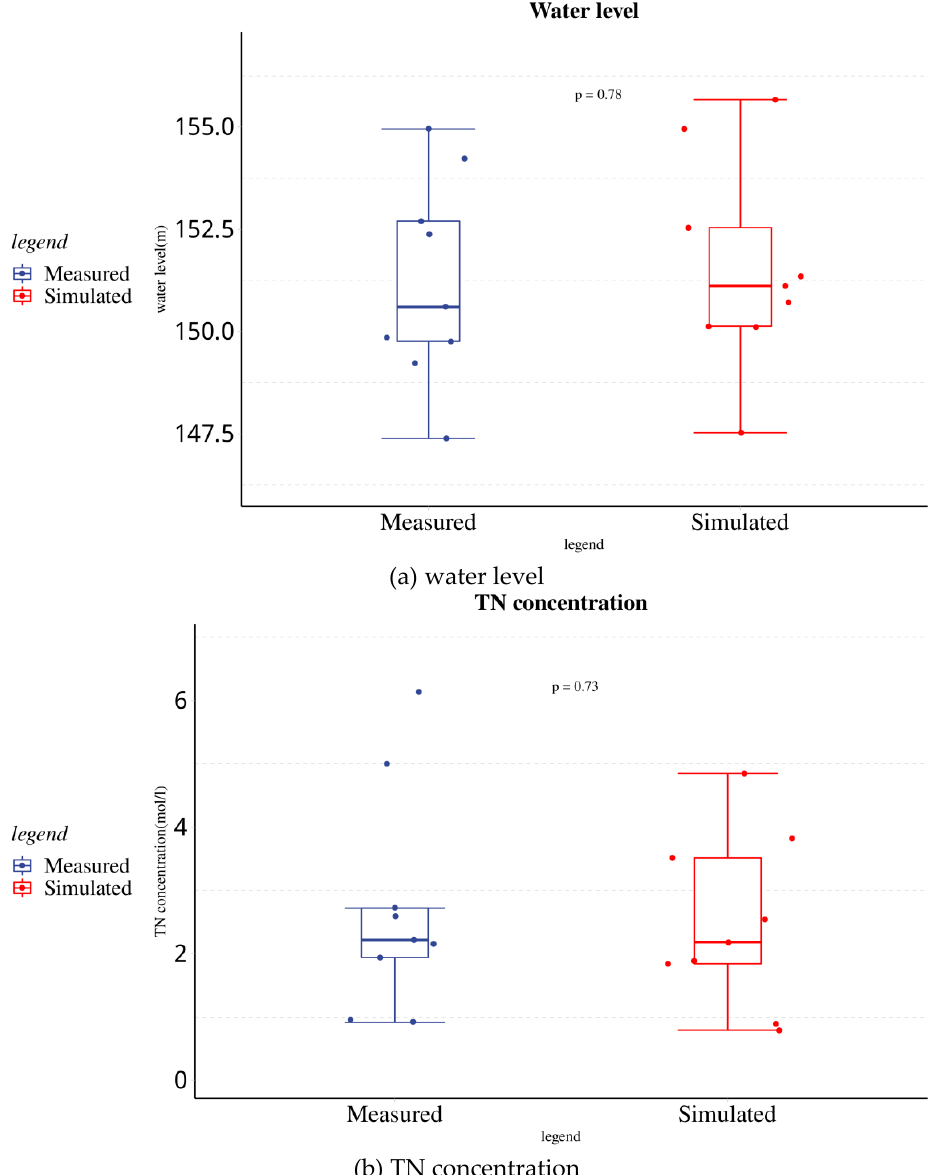
Figure 3. Error box simulation of the measured value error box plot. ( a ) water level, ( b ) TN concentration.